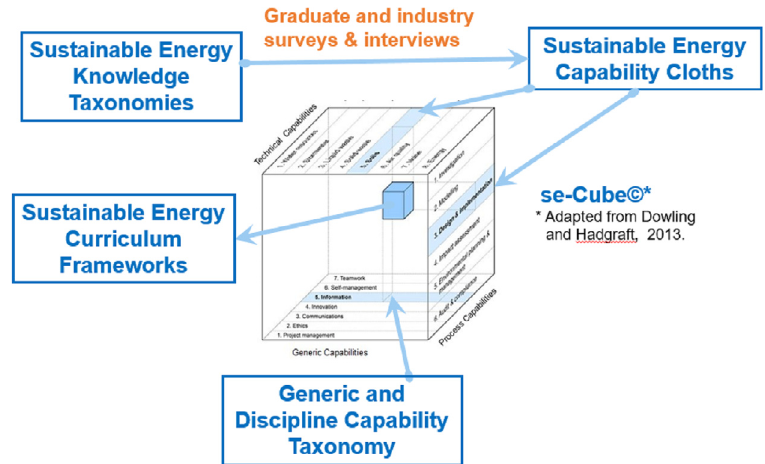
Fig. 1. Approach and methodology for developing the